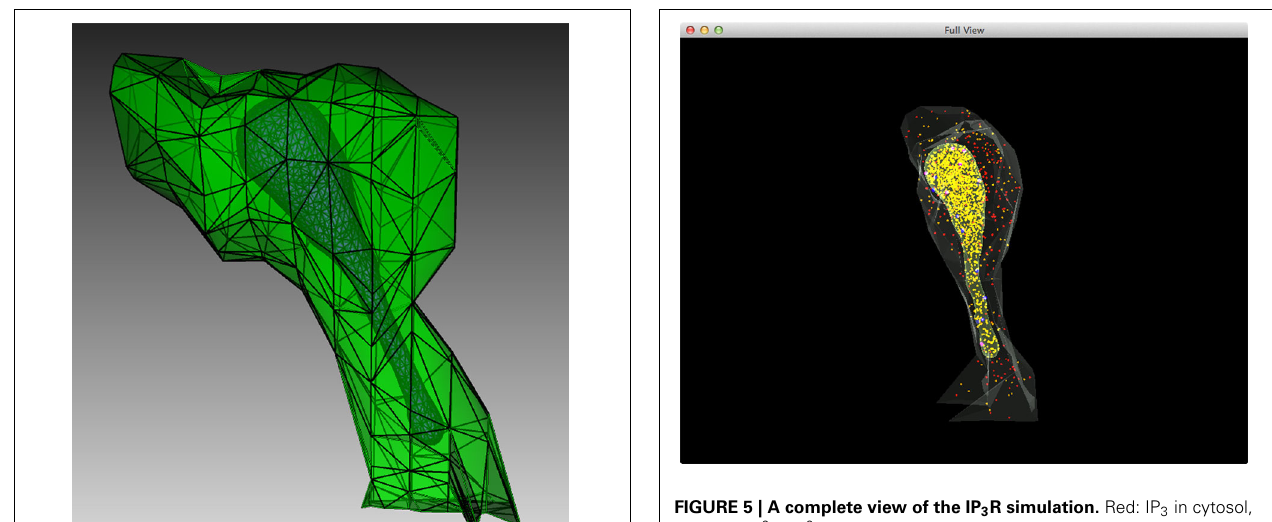
FIGURE 5 | A complete view of the IP 3 R simulation. Red: IP 3 in cytosol, Orange: Ca 2 + (Ca 2 + in ER is rendered as yellow due to the color combination with ER compartment), Blue: inactivated IP 3 receptors, Dark magenta: IP 3 bound receptors, Bright magenta: IP 3 receptors in open state.